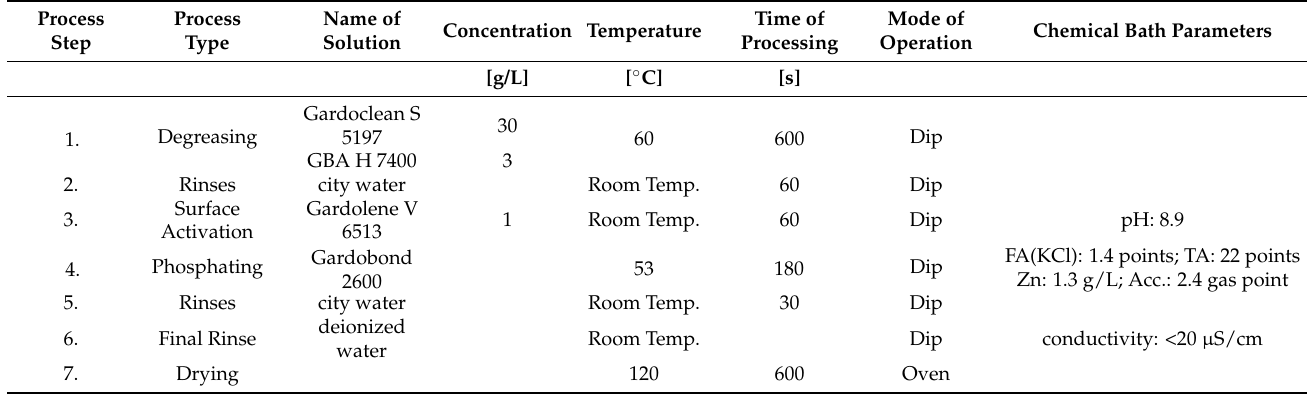
Table A2. Process parameters of zinc phosphating with nitrite